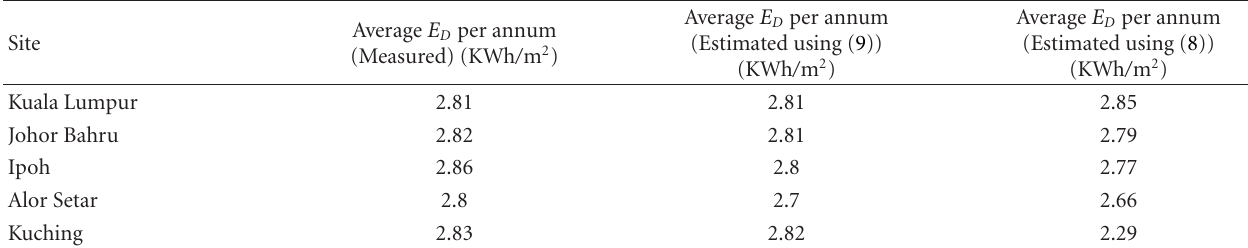
Table 3: Annual global solar radiation averages for five di ff erent sites in Malaysia.